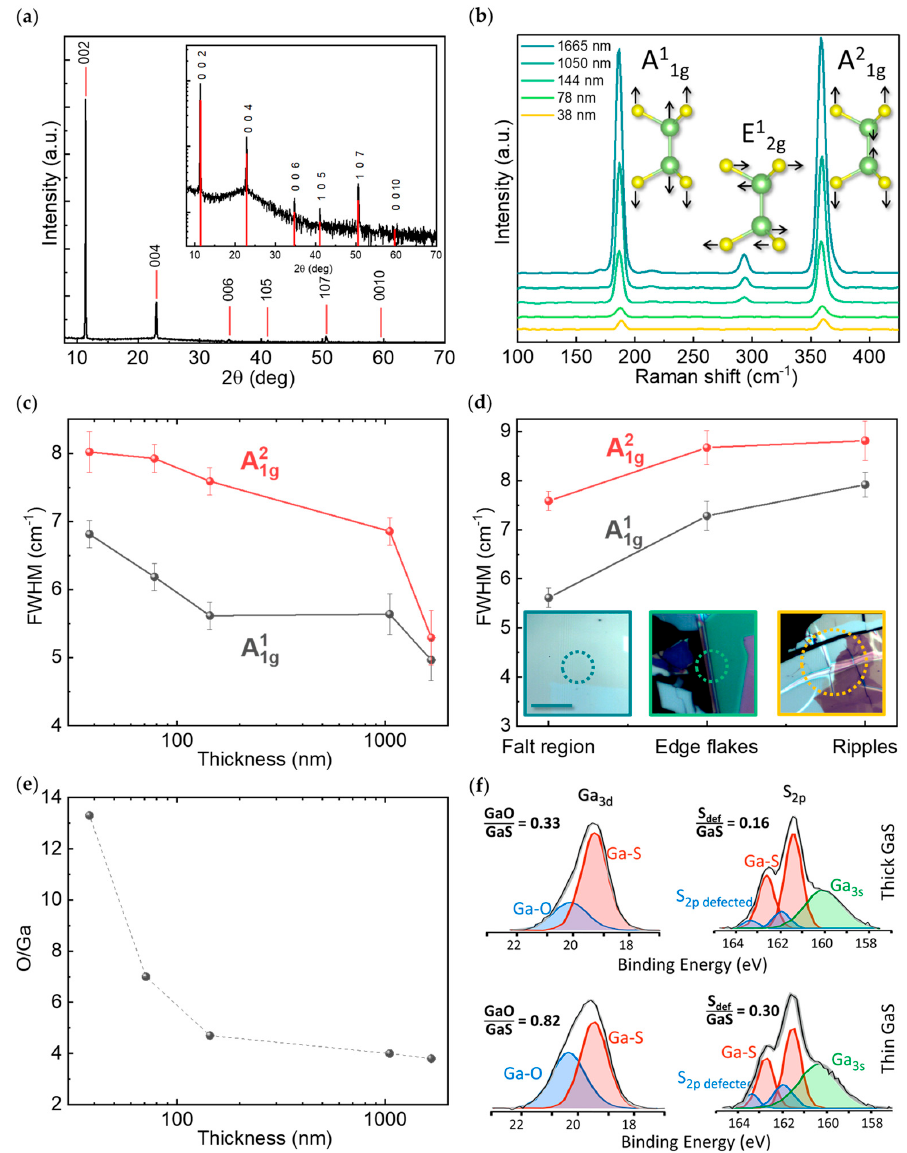
Figure 2. ( a ) XRD diagram of the 38 nm exfoliated GaS. ( b ) Raman spectra of exfoliated GaS with different thicknesses. ( c ) Dependence of the FWHM of the A 1 1g and A 2 1g modes as a function of the GaS average thickness. ( d ) FWHM of the A 1 1g and A 2 1g modes measured at the flat basal plane of the flake, at the edge of the flakes, and at the ripple position (as shown by the micrographs in the inset). ( e ) O/Ga atomic percentage ratio as determined from the Ga3d and O1s XPS peaks as a function of flakes thickness. ( f ) XPS spectra of the Ga3d and S2p photoelectron core levels for the thin and thick GaS flakes. The ratio of the Ga-oxide (GaO) to GaS fitting components from the Ga3d and that of the defective sulfur to GaS from the S2p are also indicated.